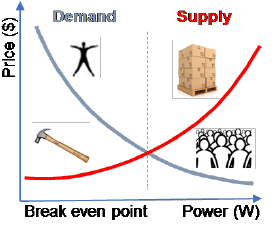
Figure 2. Supply versus demand